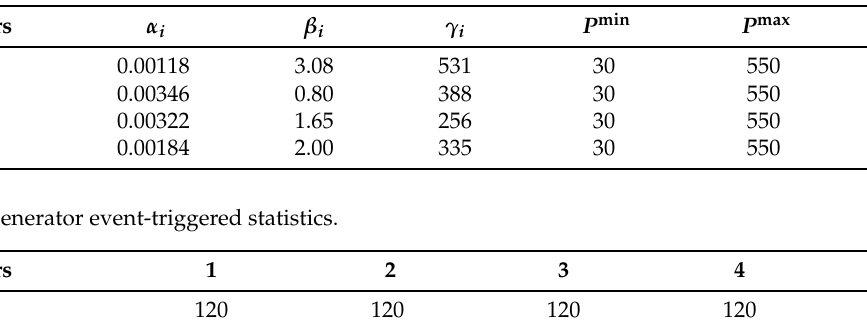
Table 1. Generator cost function coefficient.